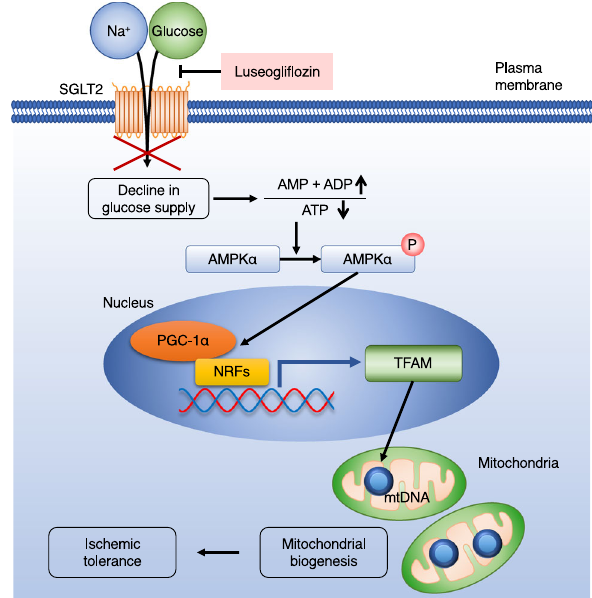
Fig. 6 Schematic model depicting SGLT2 inhibitor-mediated acquisition of ischemic tolerance in brain pericytes. Luseogli fl ozin, an SGLT2 inhibitor, inhibits Na + -dependent glucose uptake and activates AMPK α in response to depletion of intracellular glucose and ATP. Activated AMPK α enhances mitochondrial biogenesis via PGC-1 α , NRF1, and NRF2 signaling, leading to ischemic tolerance acquisition. SGLT2 sodium-glucose cotransporter 2, TFAM mitochondrial transcription factor